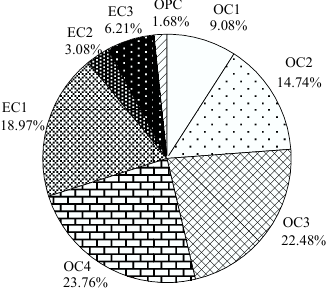
Figure 4. Percentage of eight carbon components in TC.